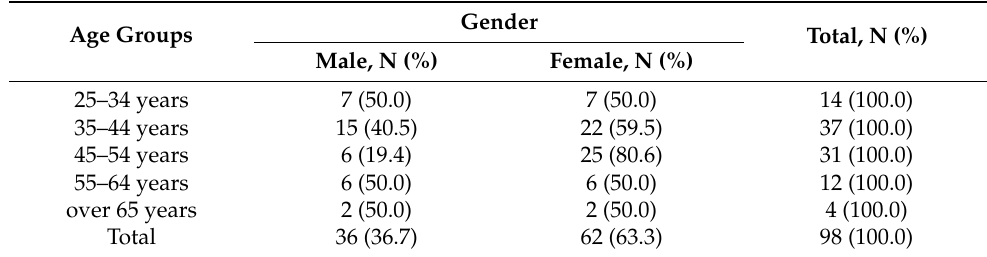
Table 1. Descriptive statistics on the distribution of study participants based on age and